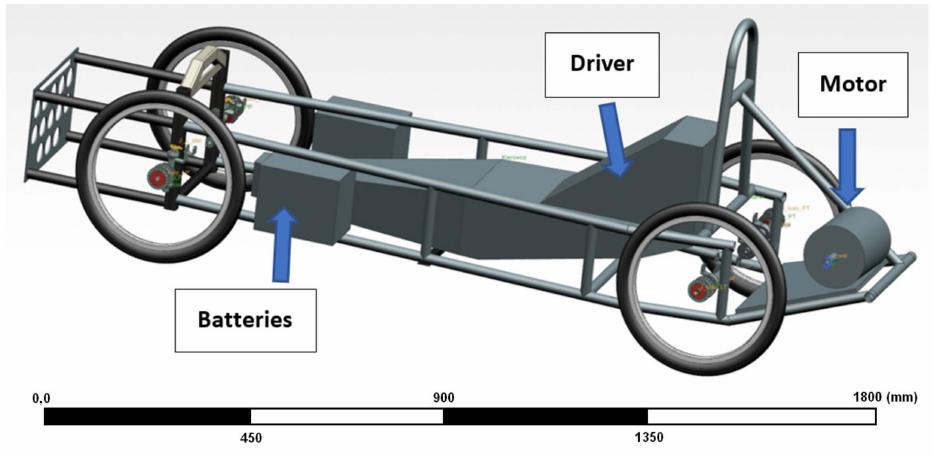
Figure 5. 3D model of the electric car used in the simulation.